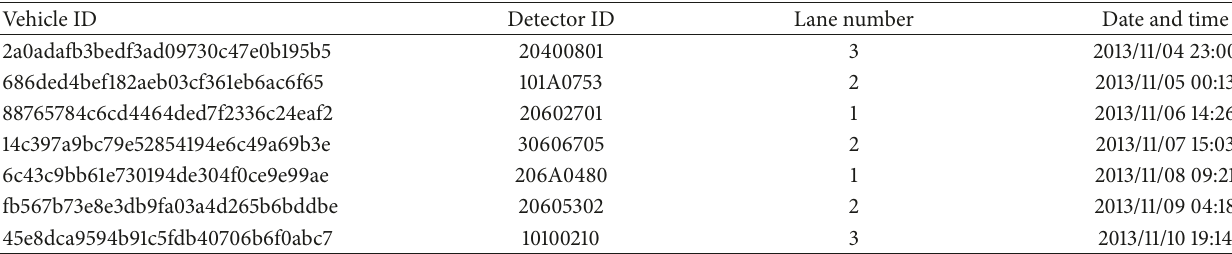
Figure 1: Road network and distribution of LPR system in Shenzhen. Table 1: Raw data